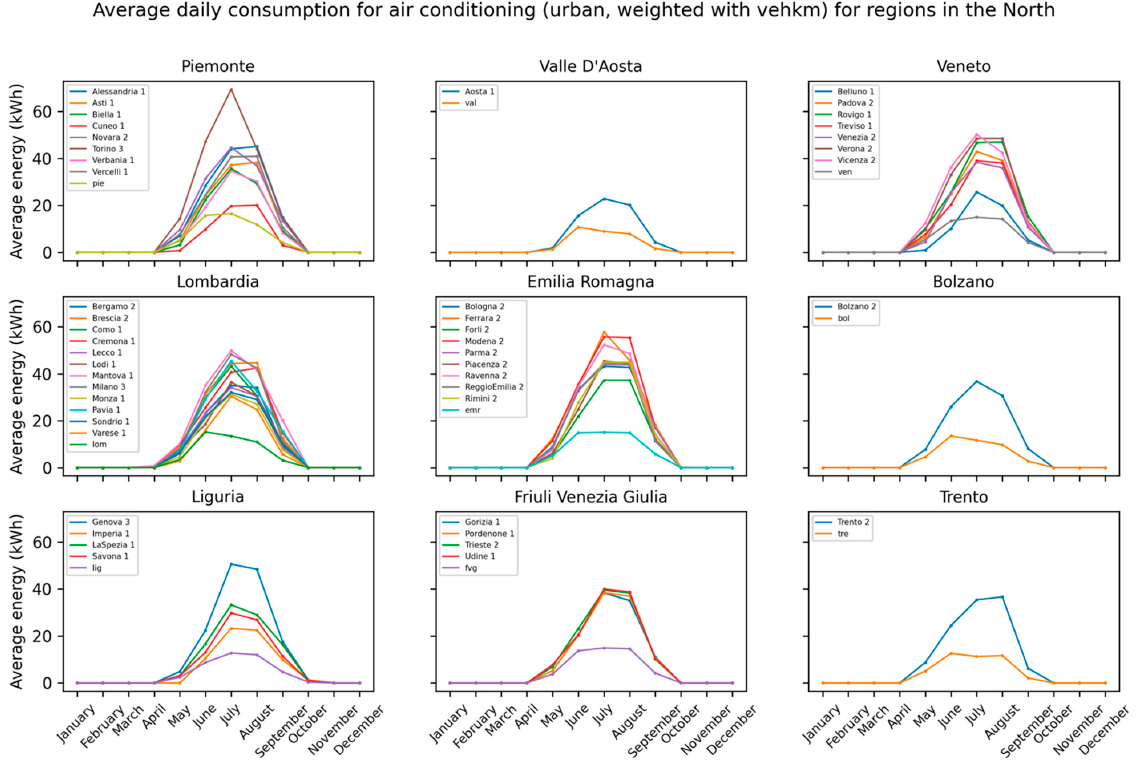
Figure 7. Reference daily air-conditioning consumption by month, obtained by using the hourly mileage distribution of the fleet, Figure 6, to compute the hourly usage of the vehicles. Each plot is referred to as the capitals of the provinces and by extension to the entire region of Northern Italy.